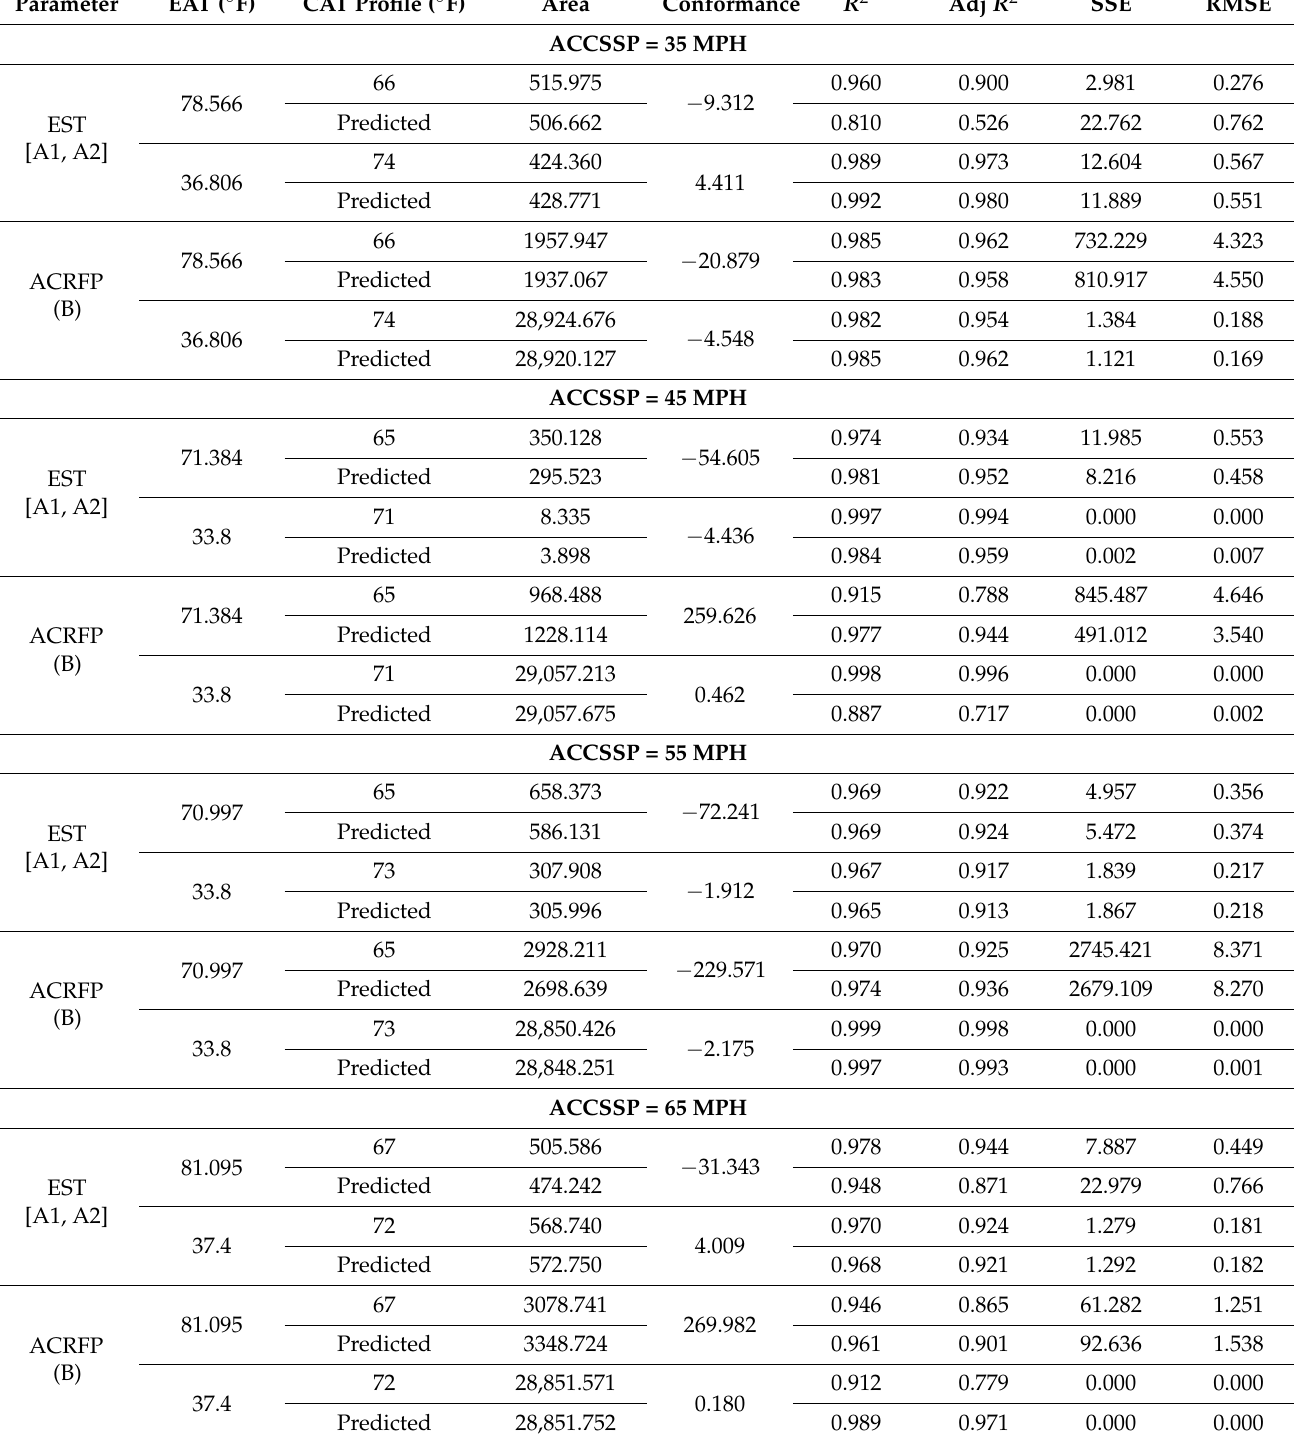
Table 8. Performance analysis—Prediction of